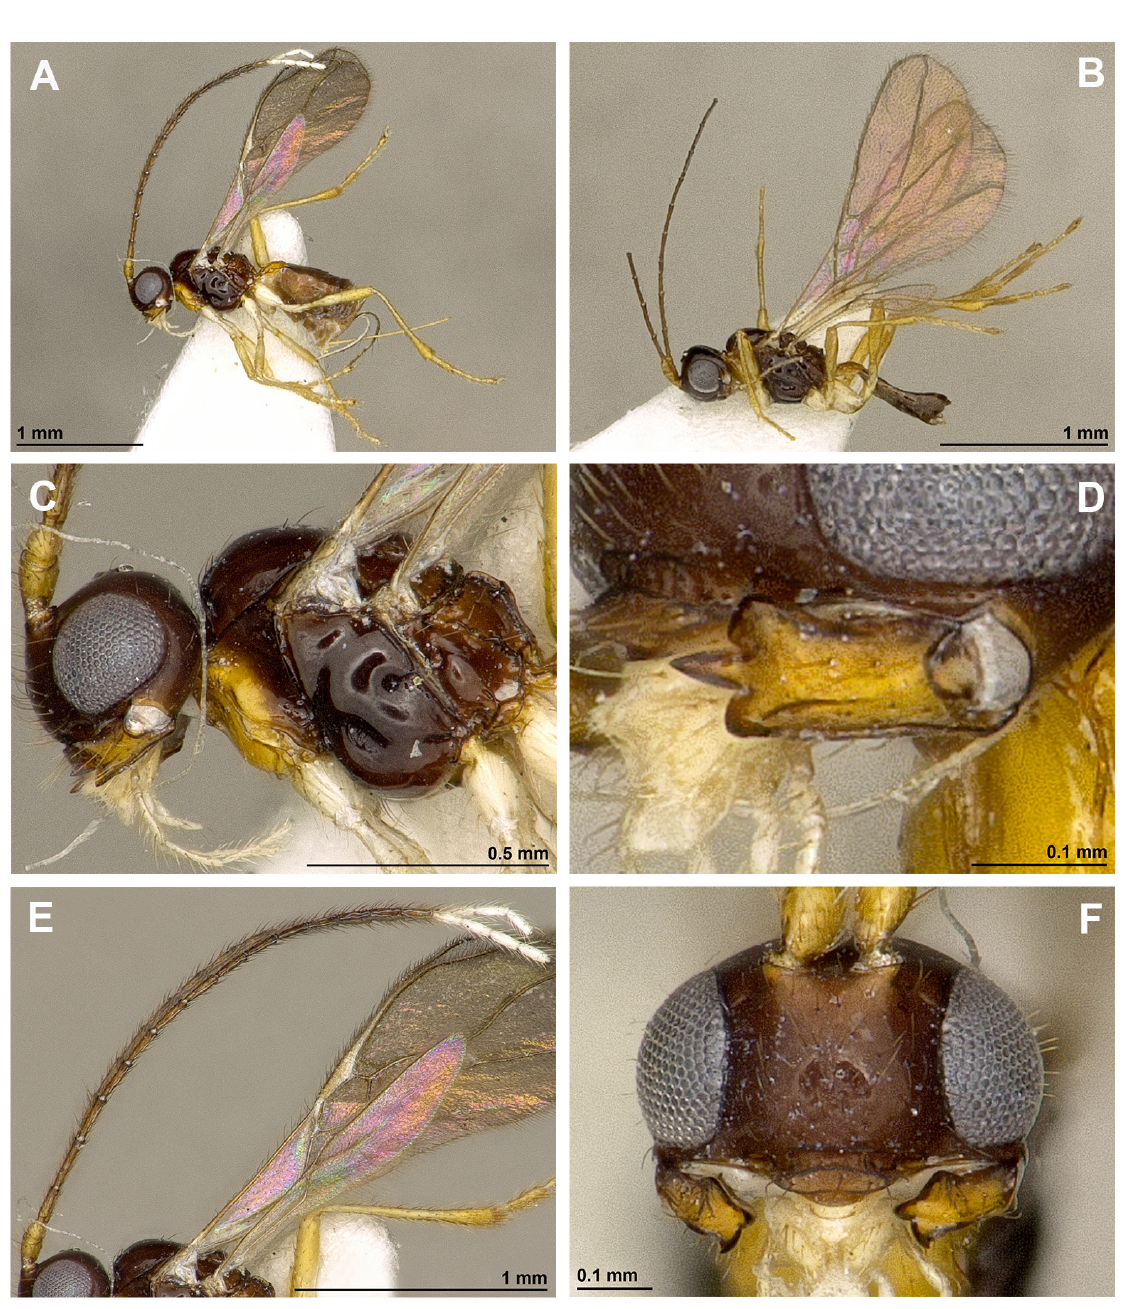
Fig. 31. Asobara kibalensis van Achterberg, sp. nov., A, C–F: ♀, holotype (RMNH); B: ♂ (RMNH). A–B . Habitus, lateral view. C . Head, lateral view. D . Mandible. E . Antenna. F . Head, front